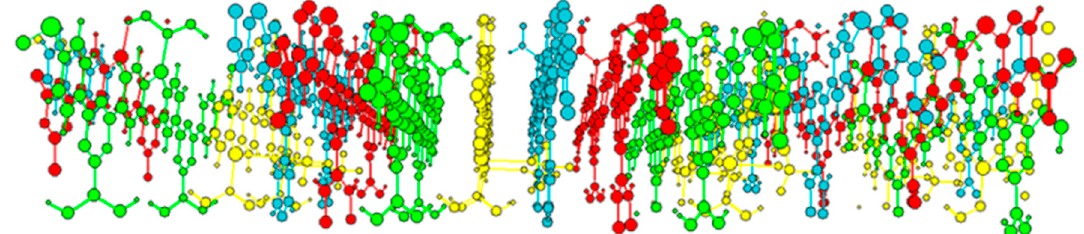
Figure 1. Depth perspective of Cu(tpt)BF 4 ·¾H 2 O skeletal framework. Hydrogen atoms omitted for clarity. Figure 2. Four-layer interpenetration arrangement of Cu(tpt)(BF 4 )·¾H 2 O crystal structure. Guest species omitted for clarity.